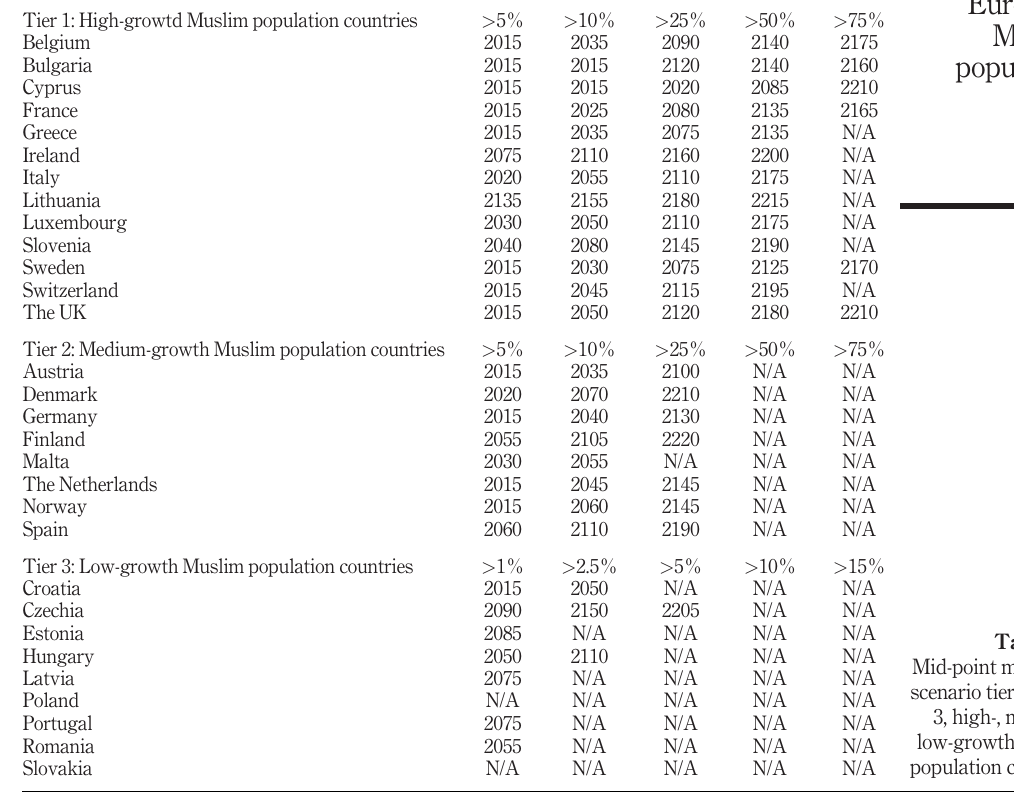
Table III. Mid-point